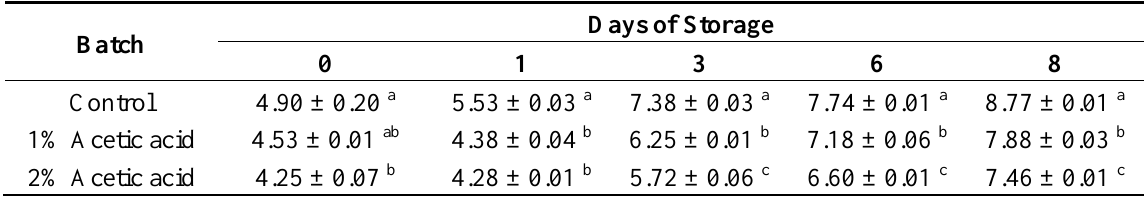
Table 4. The effect of acetic acid on Listeria monocytogenes counts on poultry legs (log